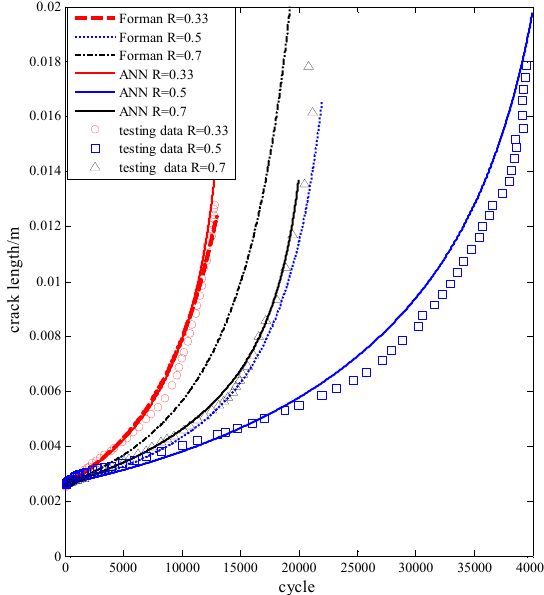
Figure 13. The predictions vs. the experimental data for Al7075-T6 aluminum alloy.